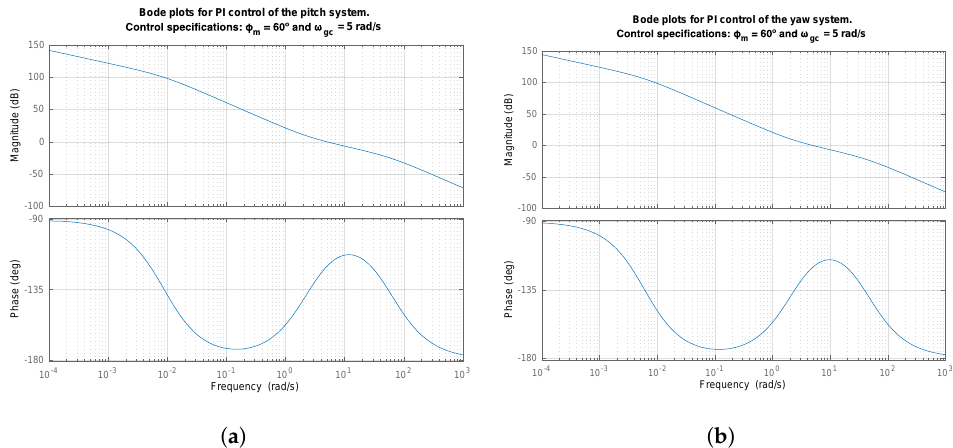
Figure 11. Bode plots of the open loop systems with the resulting PI controllers. Control specifications: φ m = 60 ◦ and ω gc = 5 rad/s. ( a ) Bode plots of the open loop system with the PI controller corresponding to the pitch system. ( b ) Bode plots of the open loop system with the PI controller corresponding to the yaw system.